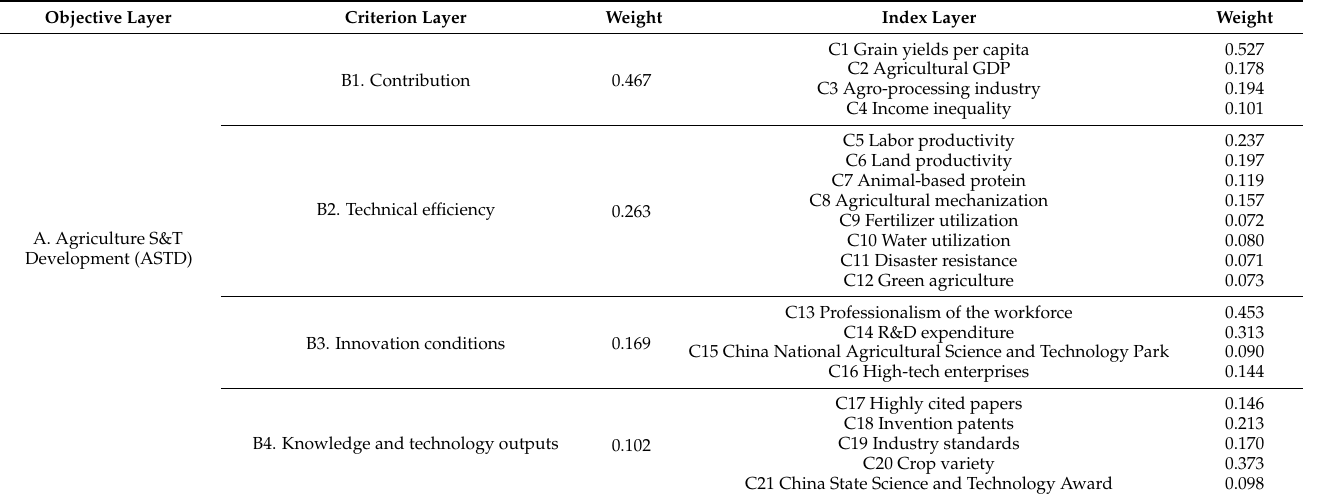
Table 2. Weights of the indicator